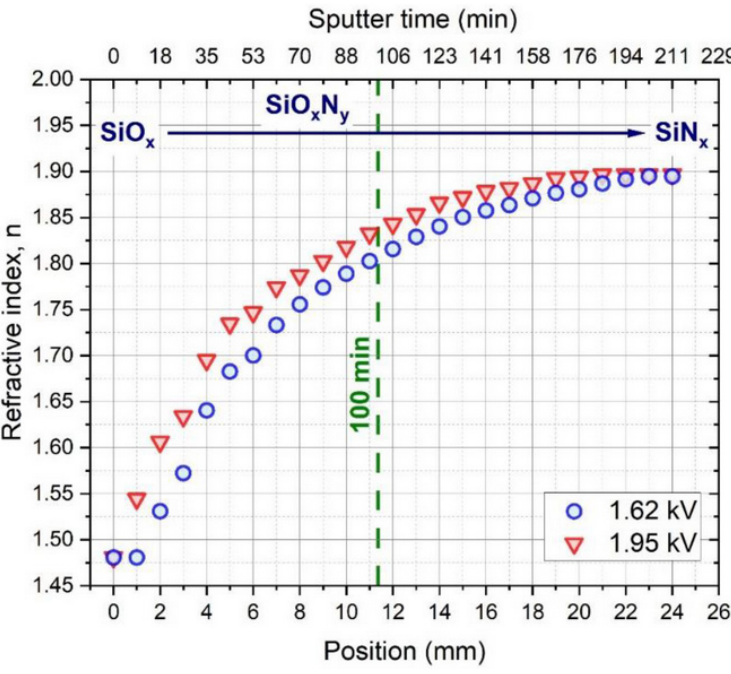
Figure 17. Refractive index ( n ) of samples of varying compositions ranging from 1.48 to 1.89 measured along the substrate by spectroscopic ellipsometry. Reproduced with permission from [76]. Copyright © 2022, MDPI, Basel, Switzerland.